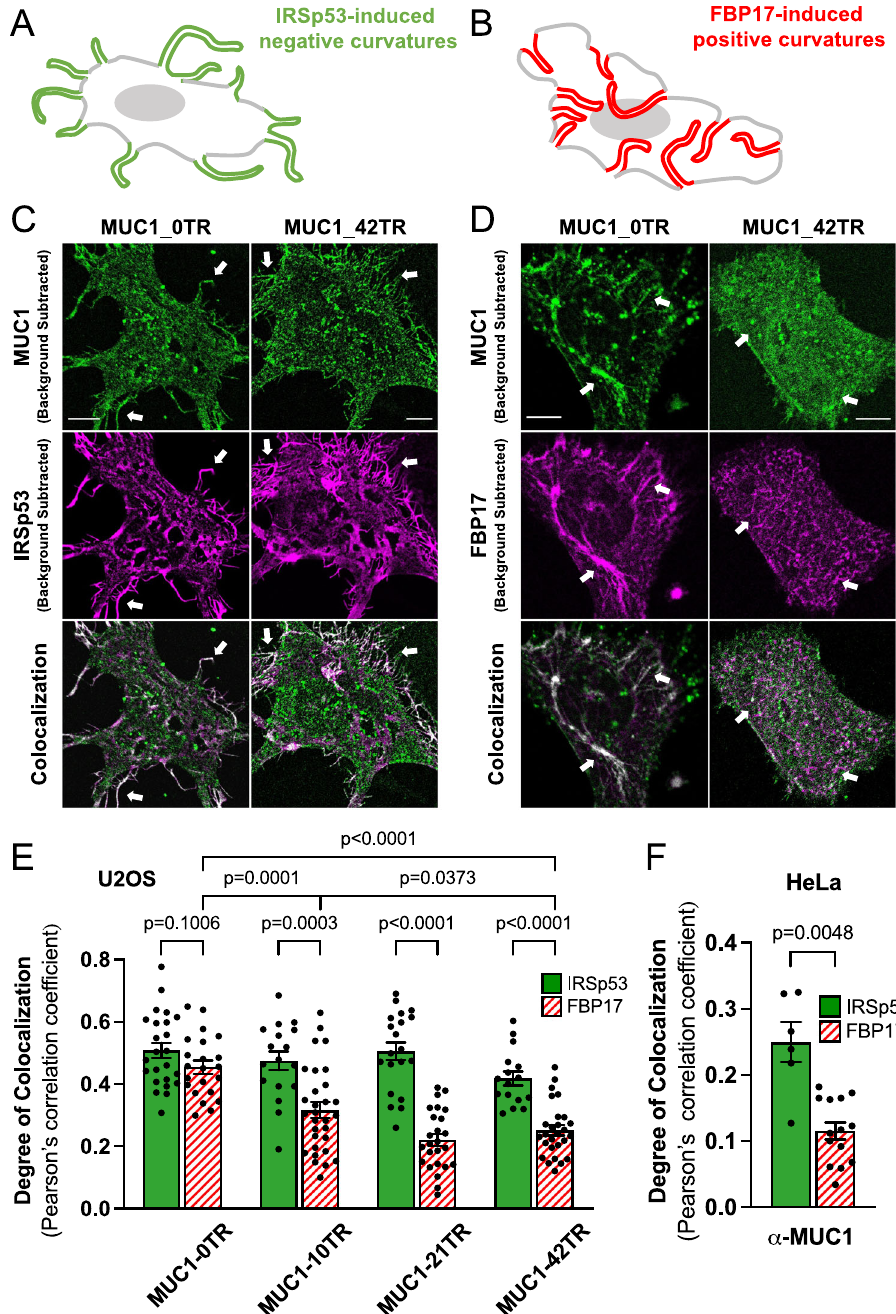
Fig. 3 MUC1 avoids positively-curved membranes and prefers negatively-curved ones induced by membrane-sculpturing proteins. A , B Schematic illustrations of A IRSp53-induced negative membrane curvature and B FBP17-induced positive membrane curvature. C , D Confocal images of U2OS cells transfected with either MUC1_0TR-GFP or MUC1_42TR-GFP and co-transfected with either C IRSp53-mCherry to induce membrane protrusions with negative curvature; or D mCherry-FBP17 to generate membrane invaginations with positive curvature. Scale bars represent 10 µ m. E Colocalization analysis of MUC1s of four lengths and two mCherry-BAR-family proteins in U2OS cells shows that longer MUC1s with 21TRs and 42TRs are preferentially excluded from FBP17-induced membrane invaginations (see Supplementary Table 4A, B for the detailed statistics). F Colocalization analysis of MUC1 and two mCherry-BAR-family proteins in Hela cells shows a similar trend (see Supplementary Table 4C for the detailed statistics). All cells were cultured on fl at surfaces. Welch ’ s t -tests (unpaired, two-tailed, not assuming equal variance) are applied for all statistical analyses in this fi gure. Error bars represent SEM. Arrows were drawn for guidance FBP17 show drastic growth of invaginations shown as tubules consistent with the pattern of a curvature insensitive membrane or puncta in the cell interior. Both MUC1_42TR-GFP and marker protein (Fig. 3D). On the other hand, MUC1_42TR-GFP MUC1_0TR-GFP colocalize with the IRSp53-induced membrane shows little or no overlap with the FBP17-induced membrane protrusions at the cell periphery (Fig. 3C). MUC1_0TR-GFP also invaginations (Fig. 3D). Colocalization was quanti fi ed by image colocalizes strongly with FBP17-induced membrane invaginations, registration of two-color channels after background subtraction,